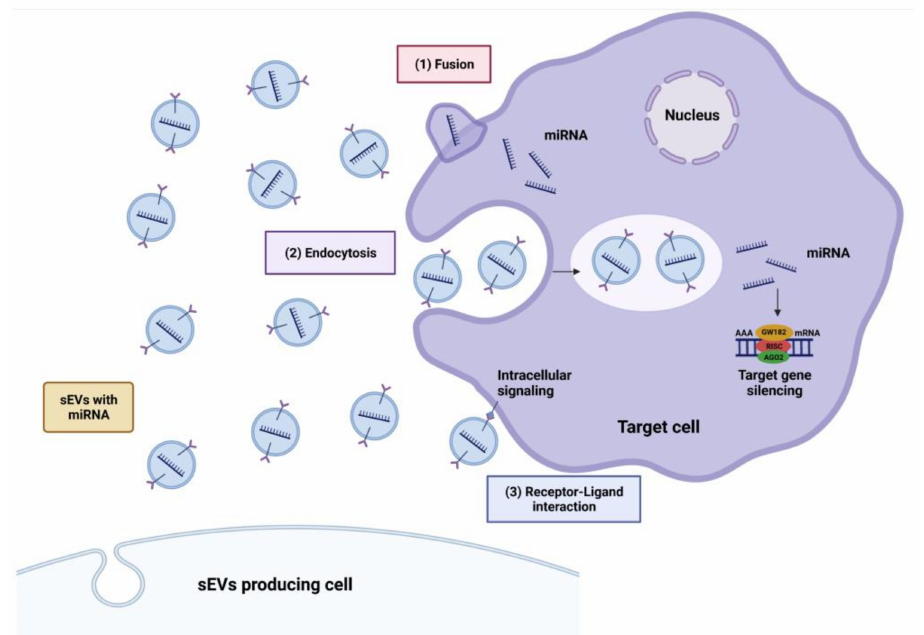
Figure 5. miRNA-enriched sEVs can be transmitted to target cells via three methods which are fusion, endocytosis, and receptor–ligand interactions (created with BioRender.com) (accessed on 13 January